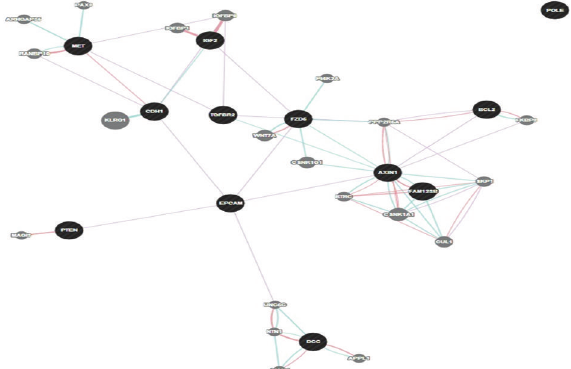
Figure 7: The network created for the overexpressed genes. Blue lines indicate pathways between spheres (Figures 6 and 7). Black spheres are query genes, and gray spheres show related or predicted genes not among the query